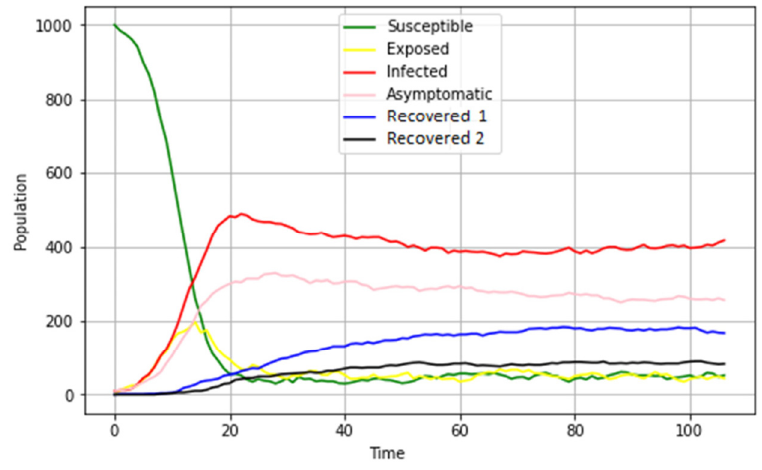
Figure 11. Dynamics of COVID-19 according to the radius of contamination equal to 5 m.